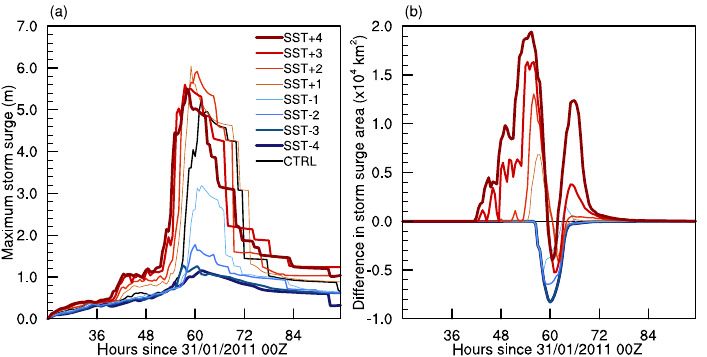
Figure 6. (a) Maximum simulated storm surge (m) for all runs. (b) Difference in storm surge area (defined as area of water levels > 1m in km 2 ) for each SST simulation minus the